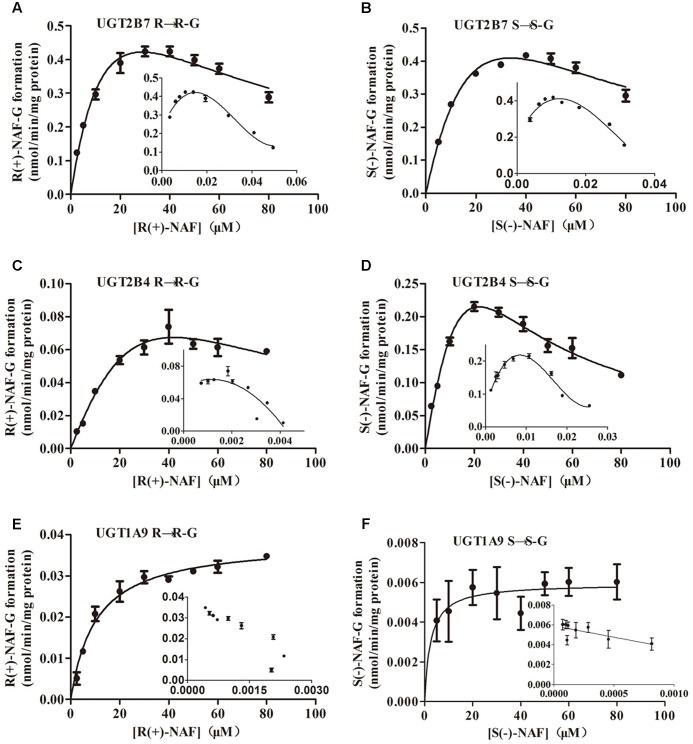
Kinetic analysis of naftopidil enantiomers conversion into their respective glucuronide conjugates by UGT1A9, UGT2B4, and UGT2B7. UGT2B7 was incubated with R(+)-NAF (A) and S(–)-NAF (B). UGT2B4 was incubated with R(+)-NAF (C) and S(–)-NAF (D). UGT1A9 was incubated with R(+)-NAF (E) and S(–)-NAF (F). For each panel, large graphs represent the Michaelis–Menten plots, while small graphs correspond to the Eadie–Hofstee plots in triplicates.